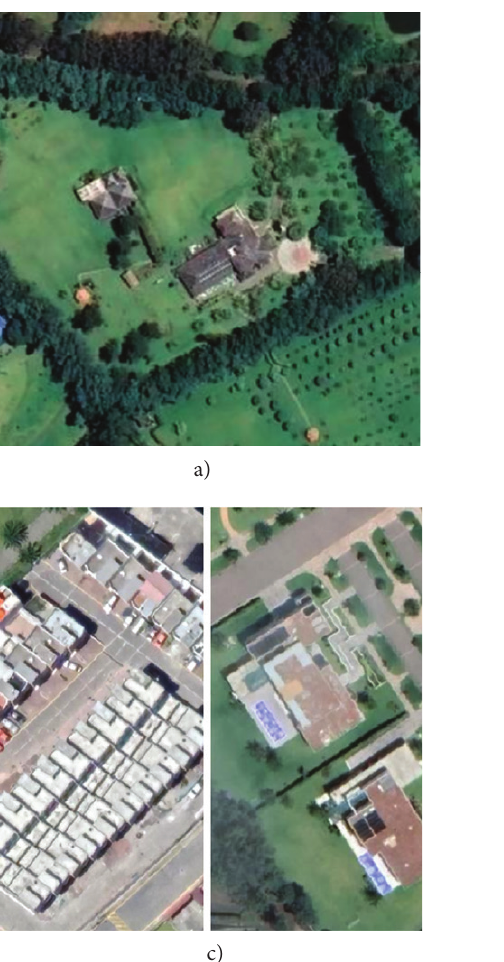
Figure 9. Urbanization patterns typologies: a) Large parcels with isolated buildings surrounded by green area. Residence in Yaruquí. Gradient 4, b) Smaller parcels with low-density buildings. Residence in Amaguaña. Gradient 1, c) Gated communities target